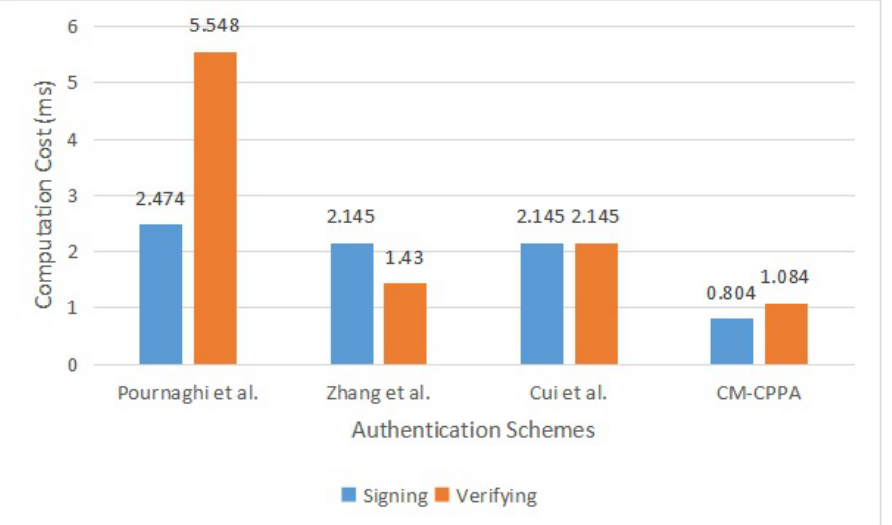
Figure 5. Computation Overhead for Message Signing and Message Verification Steps.